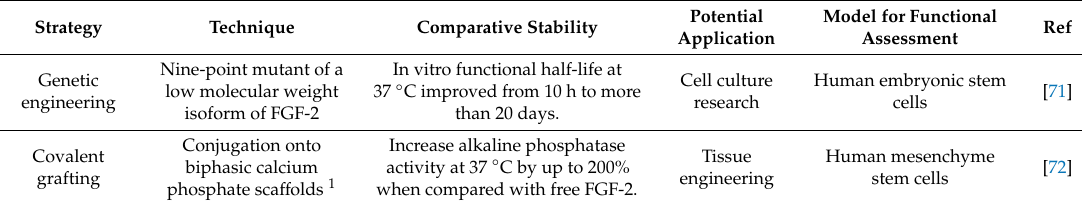
Table 2. Examples of chemical modification techniques, which have demonstrated increased stability and / or bioactivity of the modified FGF-2 compared with the unmodified FGF-2.